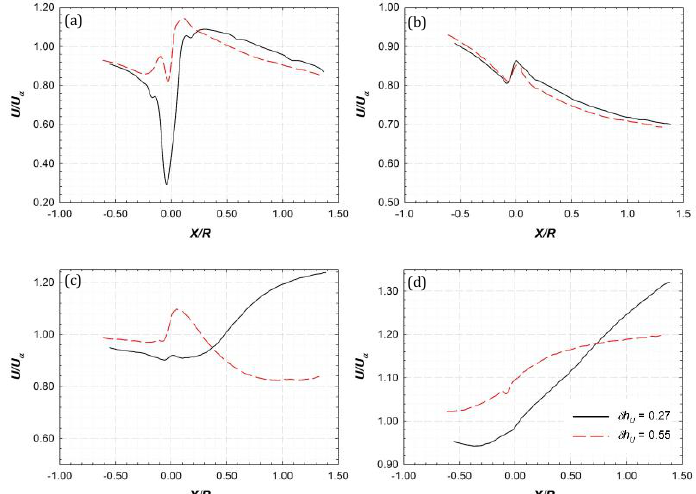
Figure 9. Variation of normalized stream-wise velocities in the upper-wake bypass region for rotational velocity of 270 RPM and tip clearance ratios of 0.55 and 0.27 on horizontal lines at various depths: ( a ) Y/ R = 0, ( b ) Y/ R = 0.5, ( c ) Y/ R = 1, and ( d ) Y/ R = 1.3.